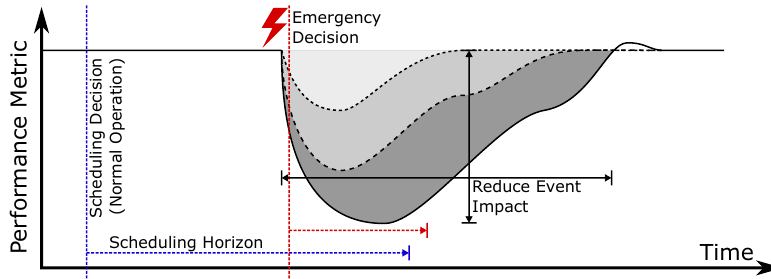
Figure 3. Resilient scheduling based on